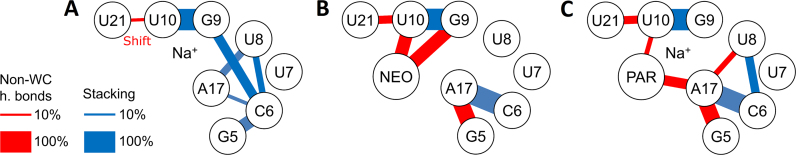
Schematic interaction map summarizing the major non-Watson–Crick hydrogen bonds and stacking interactions between selected bases and 6′ group of aminoglycosides in (A) the free riboswitch, (B) complex with NEO, (C) complex with PAR. The width of red and blue lines indicates the percentage of simulation frames in which these interactions were present. For clarity, the interactions observed in <10% of frames and the stable stacking between G5 and G9 in all simulations are omitted. High Na+ density and uridine shift are symbolically marked in relevant panels.